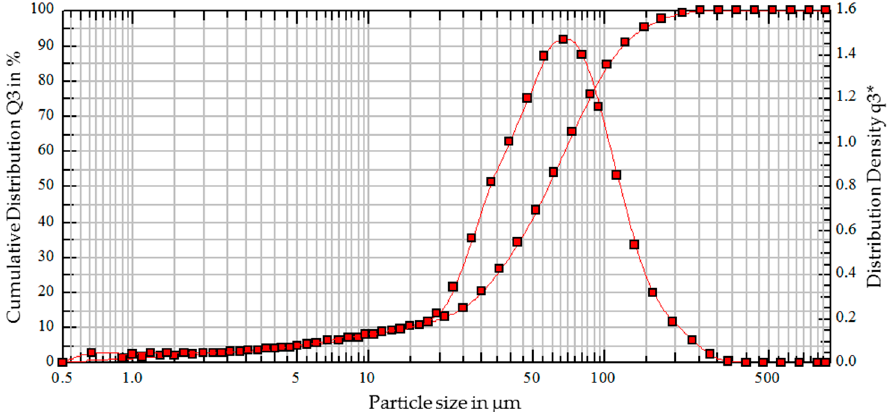
Figure 1. Particle size distribution of the monazite concentrate used in the experiments (x 10 = 14.80 µm, x 50 = 57.55 µm, and x 90 = 120.47 µm).